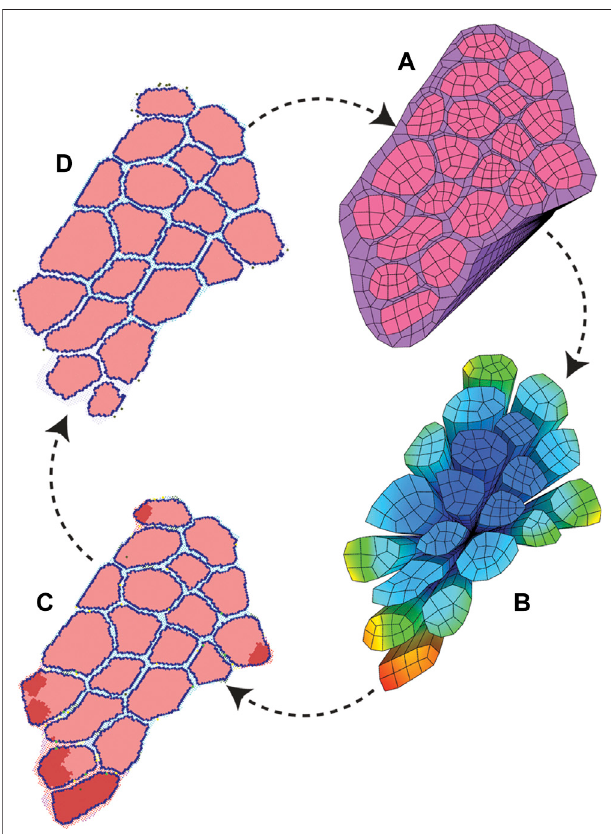
FIGURE 4 | ABM and FE modeling coupling work fl ow. The initial pixel values and coordinates were used to build both starting ABM and FE modeling geometry. (A) FE simulations were run to model active eccentric contraction of a fi ber bundle. (B) FE strain values were recorded with associated coordinate points. (C) Points of high strain were imported into the agent-based models as local damage. The agent-based models were run, and mean endpoint geometry (D) was used to generate a new FE